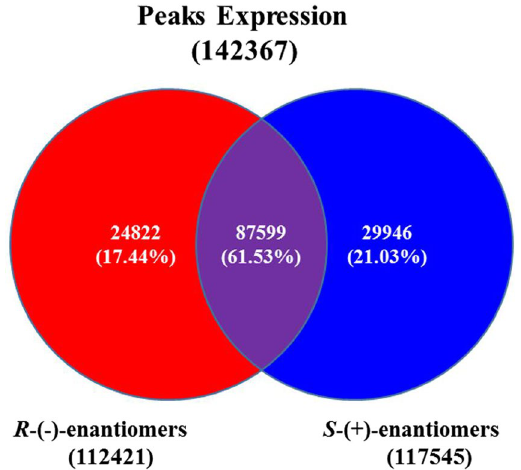
Figure 2. Regulation of global DNA methylation by fipronil ( + , − ). Zebrafish embryos were treated with 800 μ g/L of the R-( − )-enantiomer or S-( + )-enantiomer for 120 hpf. Genomic DNA was extracted and analyzed by MeDIP-Seq.